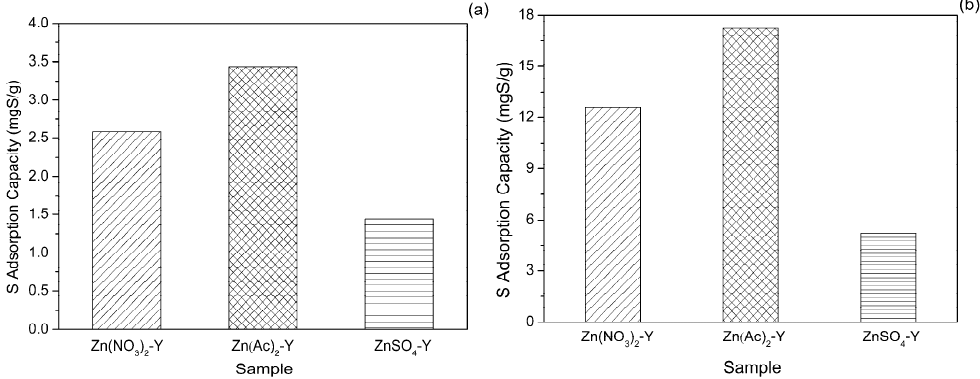
Figure 7. Effect of ( a ) aromatic and ( b ) 1-hexene on sulfur adsorption capacity (initial sulfur concentration: 1000 ppmw, t = 2 h, T = 30 °C, adsorbent dosage = 20 g/L; ion-exchange time: 10 h, ion-exchange temperature: 60 °C).